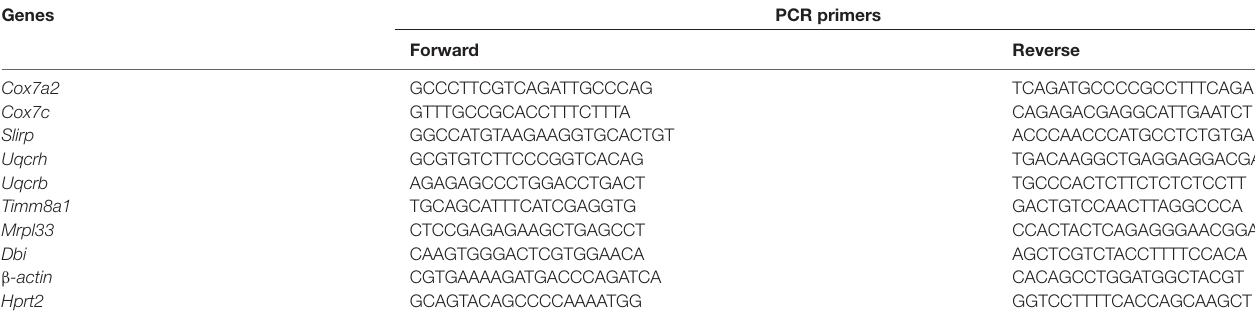
TABLE 2 | Sequences of PCR primers.